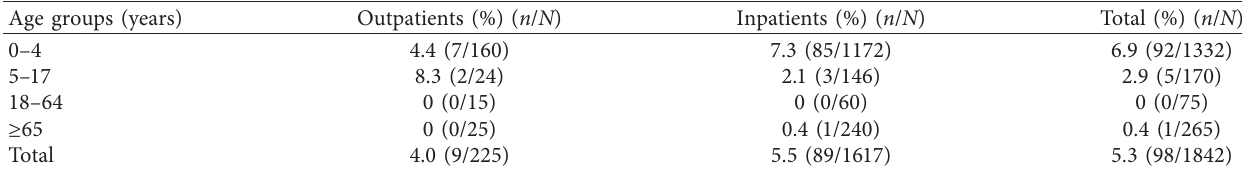
Figure 1: Distribution of different respiratory viruses detected in patients with ARI, Bulgaria, 2016–2019. Table 1: Distribution of hBoV-positive cases among outpatients and